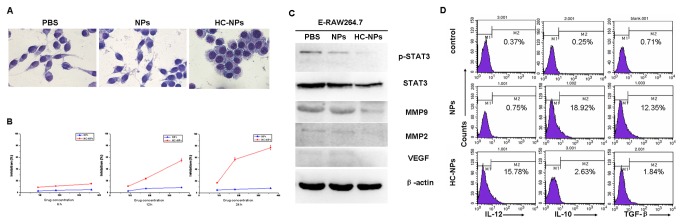
HC-NPs “re-educate” TAMs phenotype from M2 to M1 following STAT3 suppression.(A) HC-NPs affected morphological changes of E-RAW264.7 cells; PBS, NPs, HC-NPs represented cells were treated with PBS, NPs, 180µM HC-NPs for 12 hours respectively (Wrights staining, Magnification×100.0). (B) MTT demonstrated HC-NPs inhibited growth of E-RAW264.7 cells in a manner of time-concentration-dependence, after treated 6h, 12h, 24 h. (C) Decreased p-STAT3, MMP-2, MMP-9 and VEGF protein expression of E-RAW264.7 cells after treated with HC-NPs. PBS, NPs, HC-NPs represented cells were treated with PBS, NPs, 180µM HC-NPs for 12 h respectively. (D) FACS demonstrated downregulation of M2macrophages intracellular markers in RAW264.7 after treated with HC-NPs, NPs.